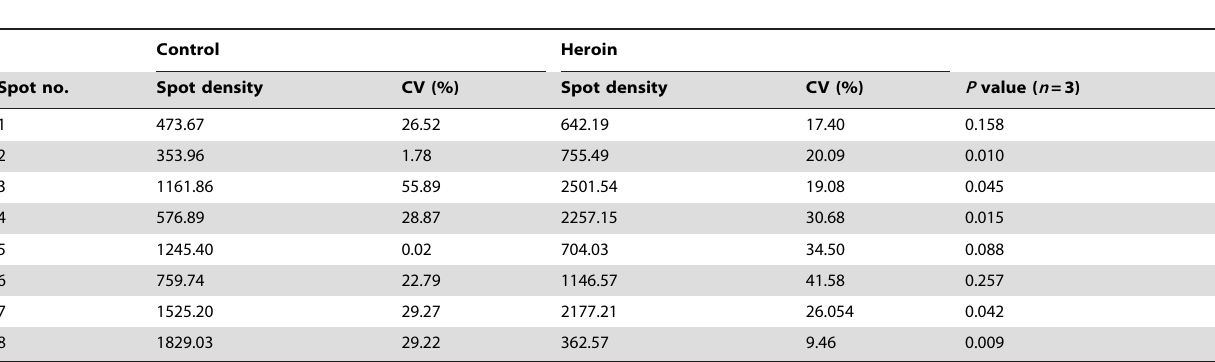
Table 2. Quantitative changes in differentially expressed proteins in controls versus heroin addicts.